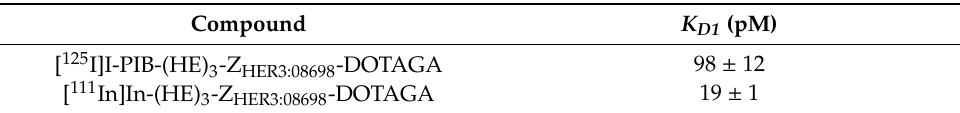
Table 2. Equilibrium dissociation constants for the interaction between radiolabeled affibody molecules and HER3-expressing BxPC-3 cells.